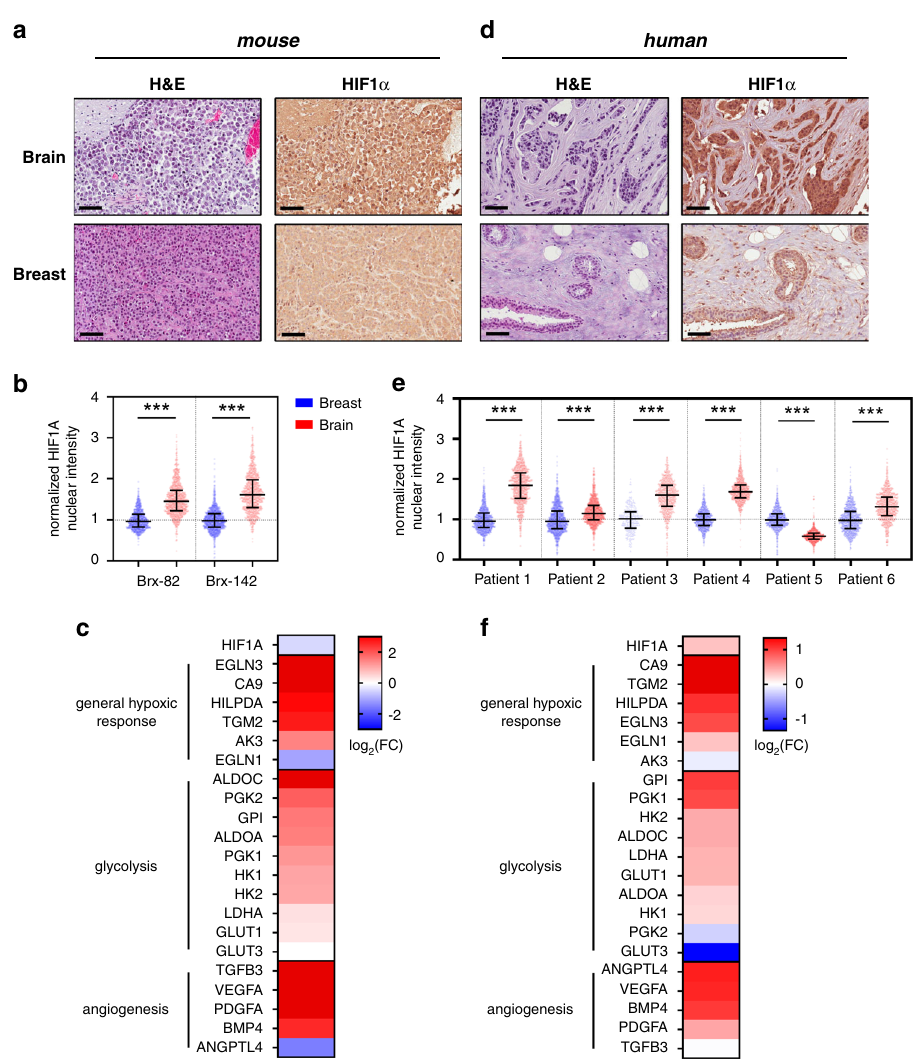
Fig. 4 HIF1A levels and downstream effectors are increased in brain metastases versus primary breast tumors. a Representative sections showing Brx- 82 brain or breast tumor histology after staining with hematoxylin and eosin; or with anti-HIF1A antibody (brown) and counter-stained with hematoxylin. Scale bars: 70 μ m. Images are representative of four tumor samples. b Quantitation of nuclear HIF1A staining in Brx-82 and Brx-142 brain and breast tumors, as determined by automated immunohistochemical staining quantitation ( n = 1000). Median normalized staining with interquartile range displayed. P values (Brx-82: 5.21 × 10 − 206 ; Brx-142: 1.28 × 10 − 242 ) calculated by two-tailed unpaired t -test. c Heat map representing the fold change of Brx- 82 brain tumors relative to breast tumors for select HIF1A downstream effectors involved in general hypoxic response, glycolysis, and angiogenesis. d Representative sections of matched patient brain metastasis and primary breast tumor histology after staining with hematoxylin and eosin; or with anti- HIF1A antibody (brown) and counter-stained with hematoxylin. Scale bars: 70 μ m. Samples displayed are from Patient 4. Images are representative of one tumor sample. e Quantitation of nuclear HIF1A staining in matched patient brain metastases and primary breast tumors, as determined by automated immunohistochemical staining quantitation (Patient no. 3 breast: n = 262; all other samples: n = 1000). Bars represent median, 25 th percentile, and 75 th percentile normalized staining. P values (Patient 1: <1 × 10 − 300 ; Patient 2: 1.39 × 10 − 36 ; Patient 3: 8.49× 10 − 87 ; Patient 4: 2.89 × 10 − 23 ; Patient 5: <1 × 10 − 300 ; Patient 6: 5.08 × 10 − 93 ) calculated by two-tailed unpaired t -test. f Heat map representing the fold change of select HIF1A downstream effectors